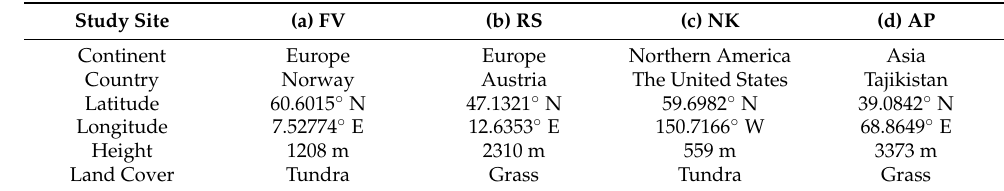
Table 1. Detailed information on the four meteorological stations selected on a global scale, including their continents, countries, names, locations, and land-cover types.